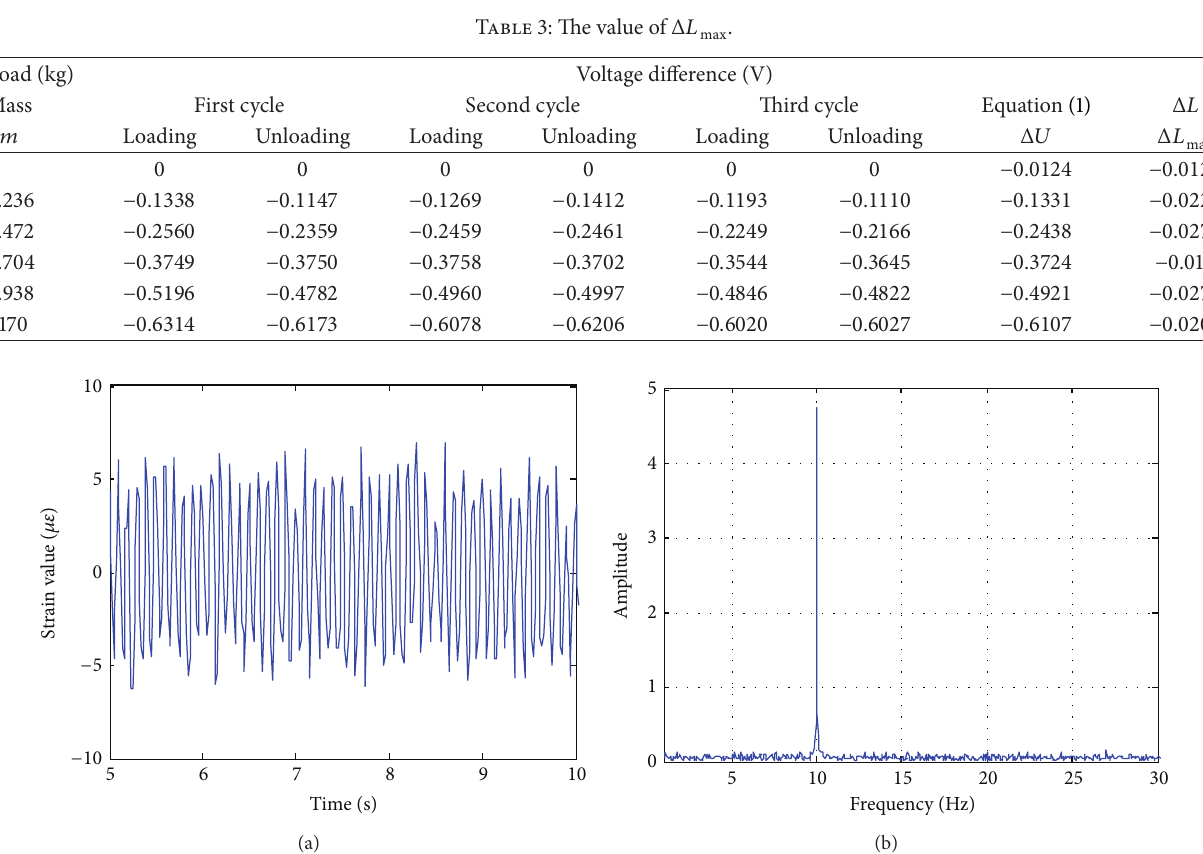
Figure 12: 10Hz input wave: (a) strain signal and (b) frequency spectrum of the